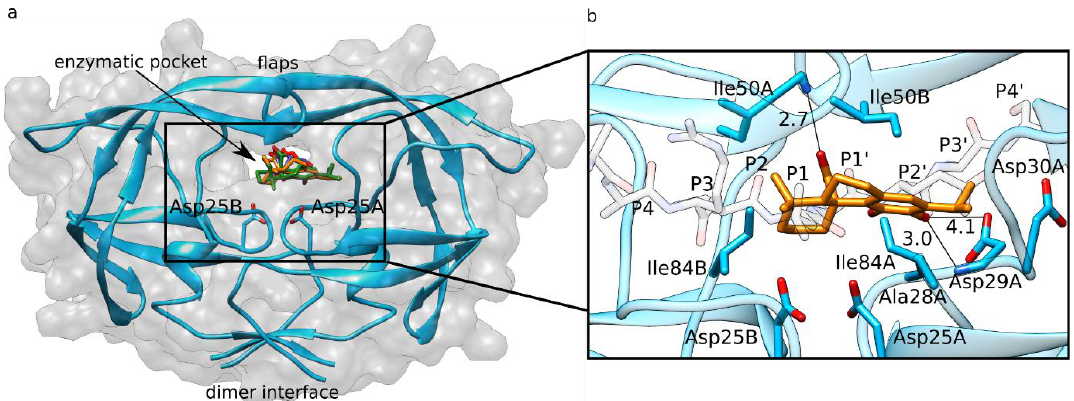
Figure 2. Overview of docked complexes. ( a ) Overlap between carnosic acid (orange), carnosol (green), and rosmanol (purple) in the binding pocket of HIV-1 protease (blue ribbons and gray surface). The enzymatic pocket, flaps, dimer interface, and catalytic aspartate are shown. ( b ) The docked pose of carnosic acid. Carnosic acid, as well as carnosol and rosmanol, form numerous hydrophobic interactions with the annotated amino-acid residues, as well as hydrogen bonds (black lines with distances in Å) with the main chain atoms and the side-chain of Asp29A. Carnosic acid also forms a hydrogen bond between its acidic group and the main chain of Ile50A. For orientation, we also depict residues Asp25A and Asp25B, which do not form direct interactions with diterpenes. In transparent sticks with gray carbons, we display the native peptide substrate (based on the PDB ID: 1F7A structure), according to which the subpockets are defined. This figure is based on the HIV-1 protease crystal structure with the PDB ID 5YOK.